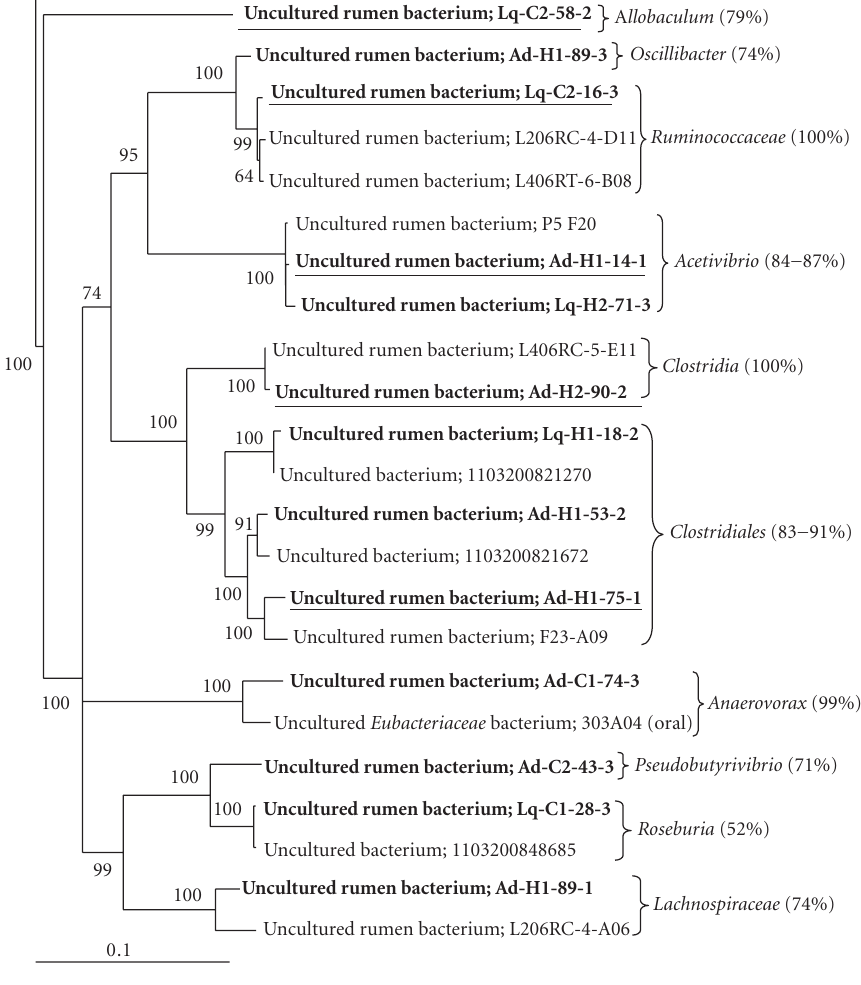
Figure 2: A Weighbor-joining tree based on the full-length sequences recovered in this study and their mostly similar sequences found in the RDP database. The taxa to which the sequences were assigned to are also shown. The values in brackets are the confidence level obtained from the Classifier program of RDP. The tree was rooted with the sequence of Lactobacillus ruminis (T); NBRC 102161. The numbers at branching points are bootstrap values based on 100 replicates. The scale bar represents 0.1 substitution per site. Sequences obtained in this study were shown in bold. The uncultured bacteria that were quantified by qPCR were also